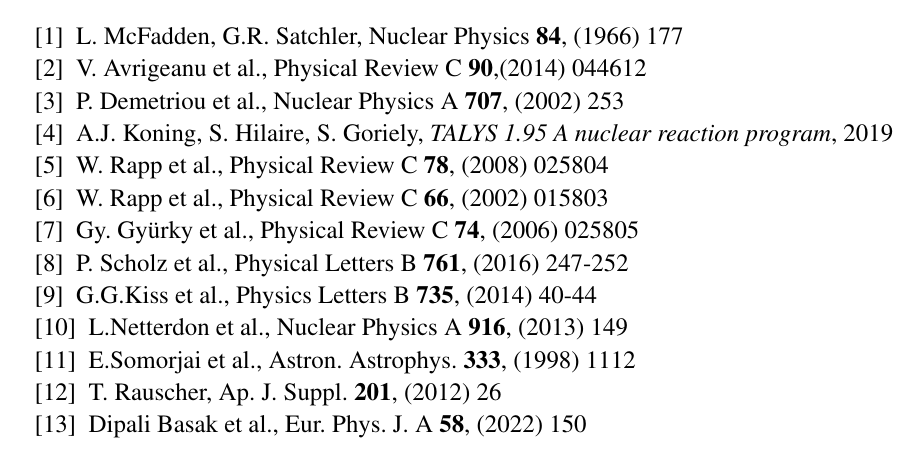
section is directly dependent on alpha width i.e on α -OMP. The modified α -OMP adequately explains the results for these nuclei. But for other nuclei, besides the α -width ( α ,n) cross section is also sensitive to the neutron and γ width. So, it was di ffi cult to extract α -OMP from ( α ,n) fitting for these higher mass nuclei. Surprisingly the results fit better for modifying only imaginary depth. The reason is that using this potential other width contribution may be eliminated. In Ref. [12], it is shown that this modified α -optical potential is explained ( α, γ ) reaction cross-section and reaction rate with proper level density model and γ -ray strength